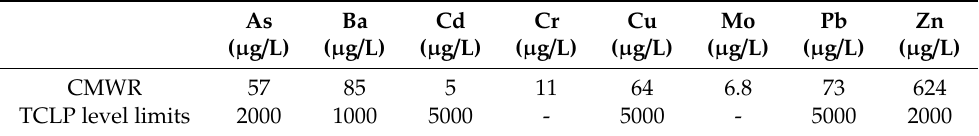
Table 6. Leaching behaviour of CMWR sample.